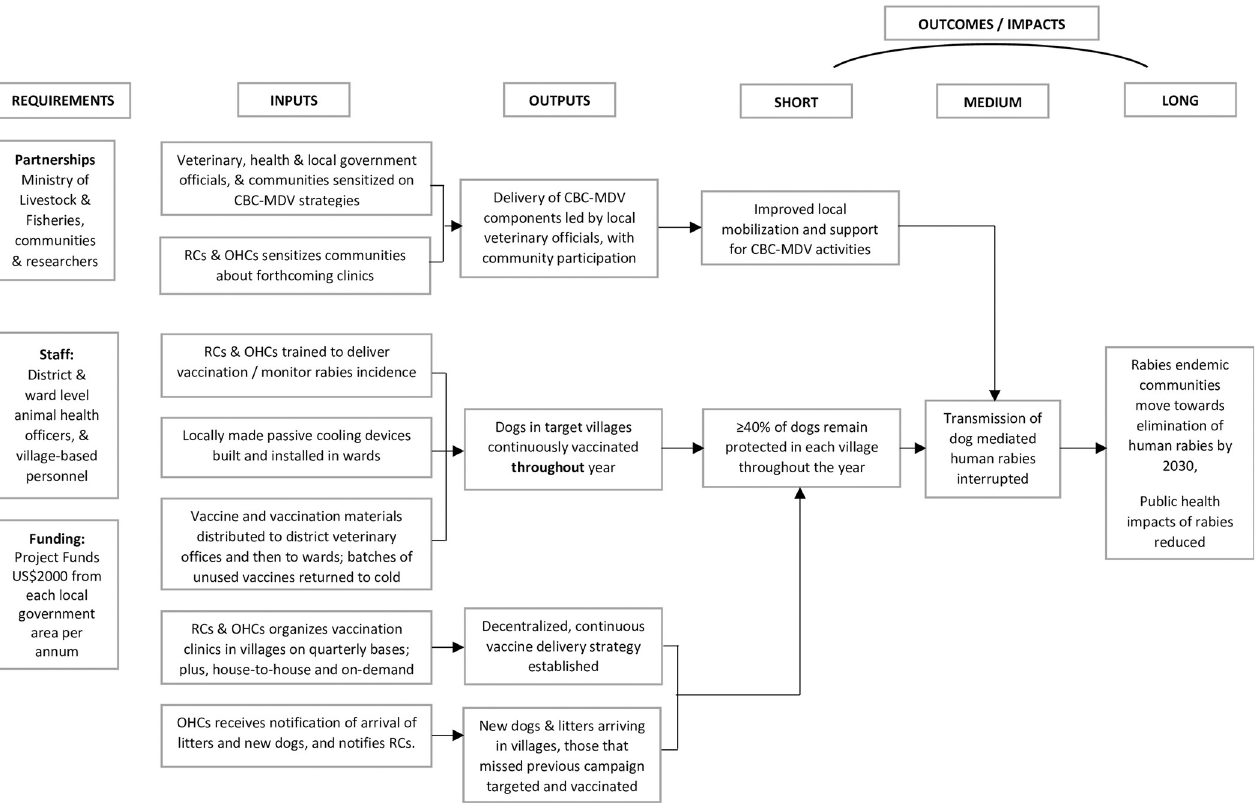
Fig 3. Logic model of the delivery and impact mechanisms of CBC-MDV